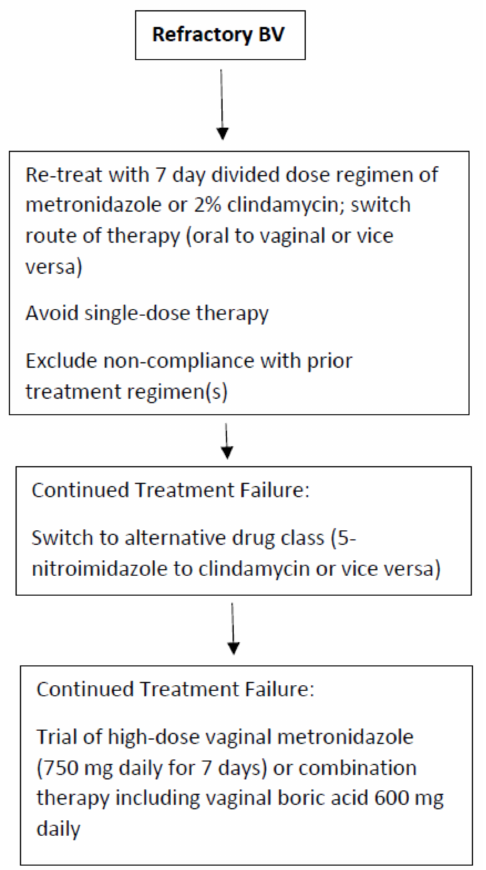
Figure 1. Recommended treatment algorithm for refractory